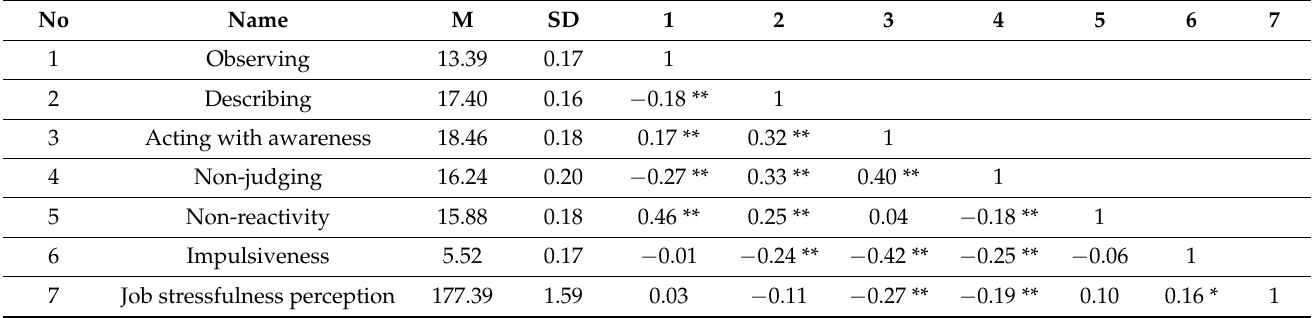
Table 3. Means, Standard Deviations, and Intercorrelations of Study Variables.